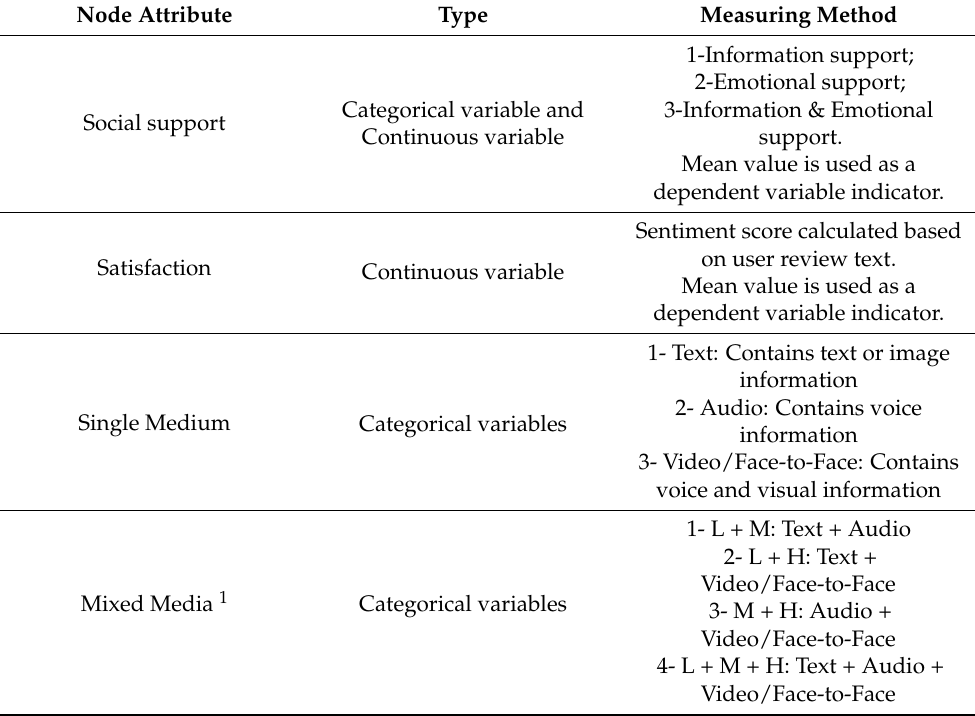
Table 1. Operationalization of